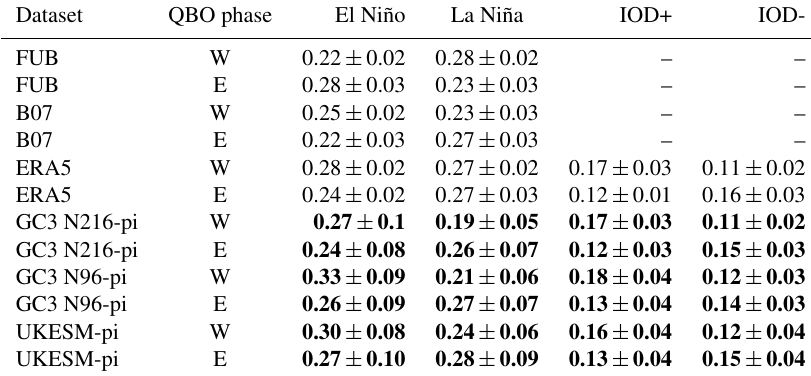
Table 1. ENSO and IOD event frequency (month per month), e.g. no. months ENSO / no. months QBO. Note that the ENSO frequencies for the probability density distribution (PDF), obtained by bootstrapping with replacement, is shown as the uncertainty of the mean value. Model results in bold indicate that the PDF for QBOW is significantly different from the PDF for QBOE to the 95% confidence level according to the KS test.